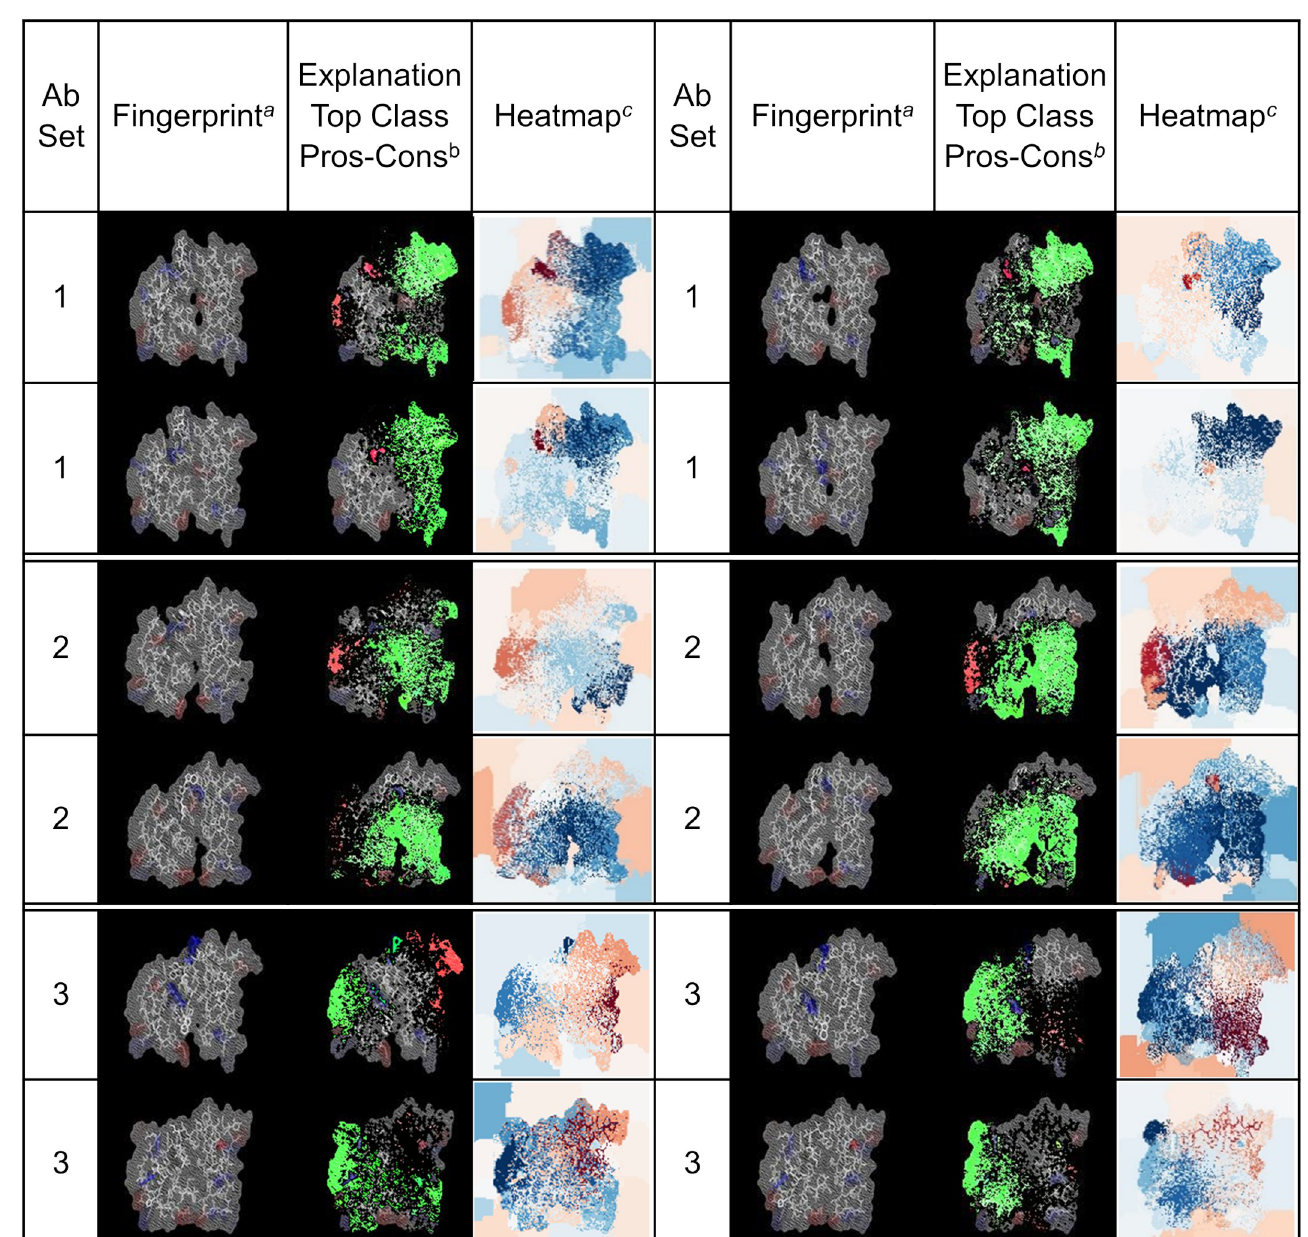
Fig 10. LIME analysis evaluating the reliability of predictions from a trained DNN model. a The column lists images of arbitrary fingerprints associated with the Abs listed under the “Abs Set” column. b The column contains images generated as the superposition of three elements, a) green color represent the most relevant pixels used by the DNN to generate the prediction, i.e., those shown in the image from column 3; b) bright red pixels have the most negative contribution to the prediction; and c) the remaining pixels from the original fingerprint image. c This column contains heatmap images describing the contribution of each pixels on the fingerprint to the prediction generated by the DNN model. The color scale ranges from dark blue for the most relevant contributions to dark red for the most negative ones. The color scale is selected independently for each heatmap based on the scores assigned by LIME.